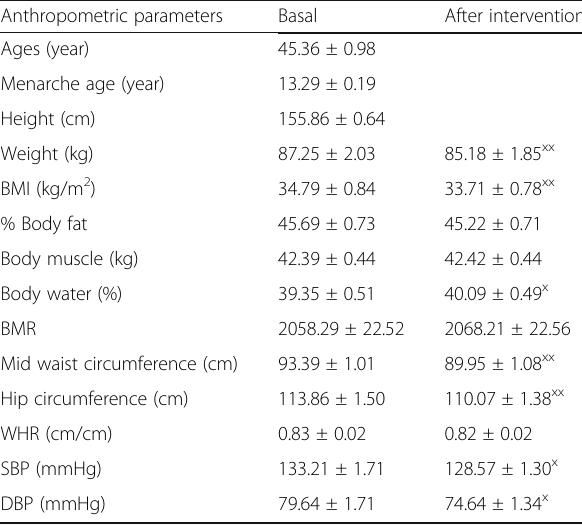
Table 6 Mean ± SE of age, anthropometric parameters, and blood pressure of the participants at the basal and last visit of the dietary therapy (no. 42)